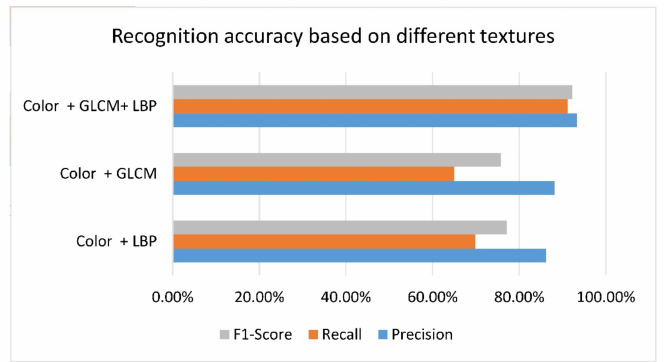
Figure 8. Comparison of the recognition effect of different texture feature combinations.